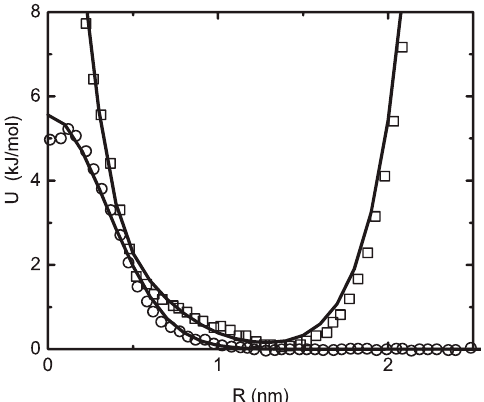
Figure 5. Potential functions for nonbonded (circles) and bonded (squares) interactions from AA simulations. The solid lines are fitted with Equations (48) and (49). Reproduced from Padding and Briels [385] with the permission of AIP Publishing.